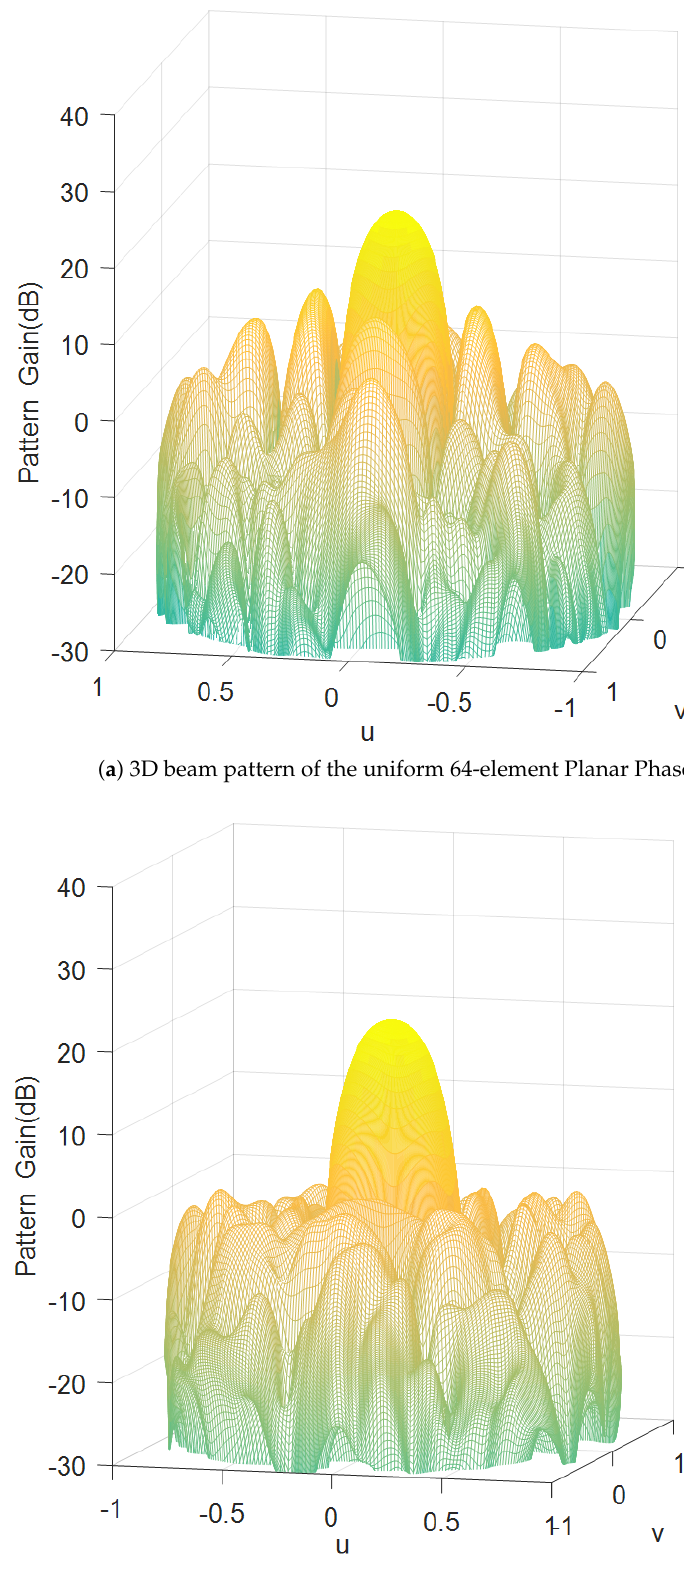
Figure 13. 3D beam patterns of 64 − element planar phased